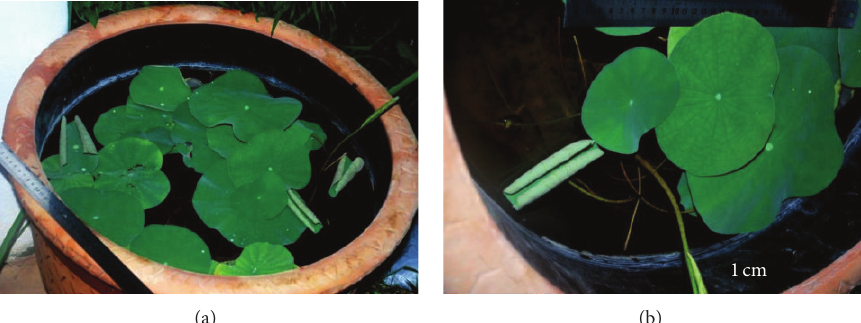
Figure 7: Eight-month-old plantlets being acclimatized in containers. (a) Green floating leaves. (b) First 3 leaves (emerged), 1 rolled leaf, and 1